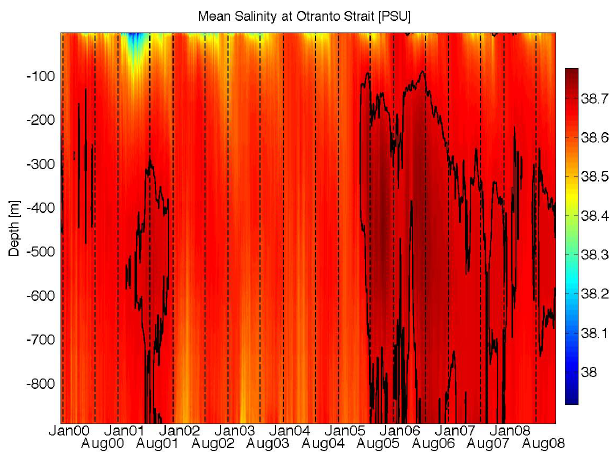
Fig. 5. Hovmoeller diagram of modelled mean salinity profile at Strait of Otranto. Y-axis indicates depth in metres; X-axis indicates time and colour indicates salinity in PSU. The solid black line indi- cates water having salinity content larger than